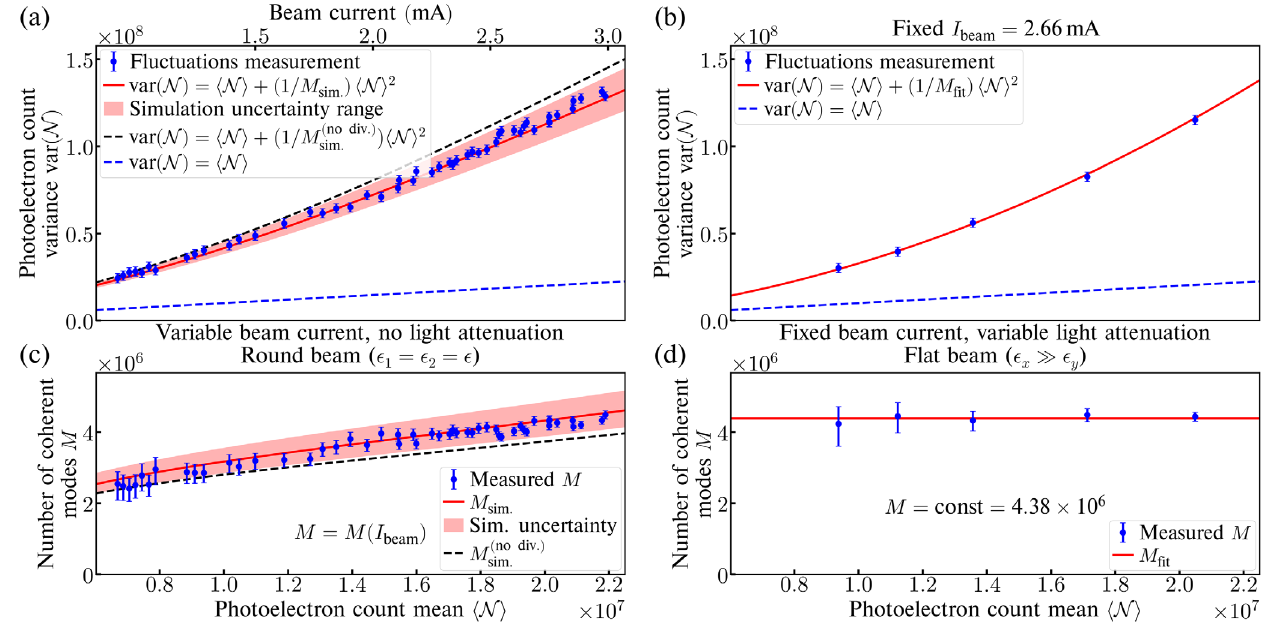
FIG. 6. (a) The fluctuations measurement for the round electron beam in IOTA as a function of beam current, a prediction by Eq. (2) (red solid line) and a prediction by [[5] Eq. (49)] (black dashed line), which does not account for the beam divergence. (b) The fluctuations measurement for the flat electron beam at a fixed beam current 2.66 mA with 4 different optical neutral density filters and one point without any filters, as well as a parabolic fit (a prediction could not be made, because the vertical emittance of the flat beam was unknown). (c) and (d) present the data of (a) and (b) in terms of the number of coherent modes M